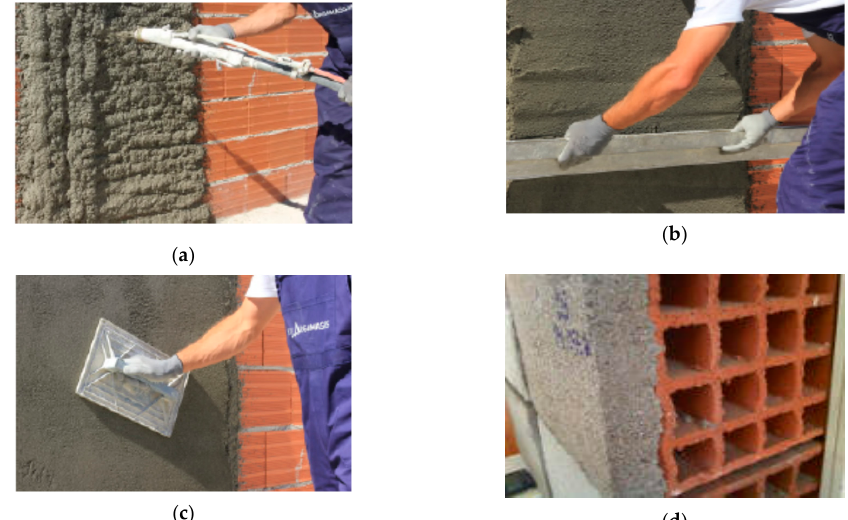
Figure 1. ( a ) Spraying application of thermal insulating rendering mortar (TIRM) with cork as lightweight aggregate; ( b , c ): Smoothing of each coat of mortar; ( d ) TIRM with cork as lightweight aggregate applied as external rendering of the external wall of a building [1,2].